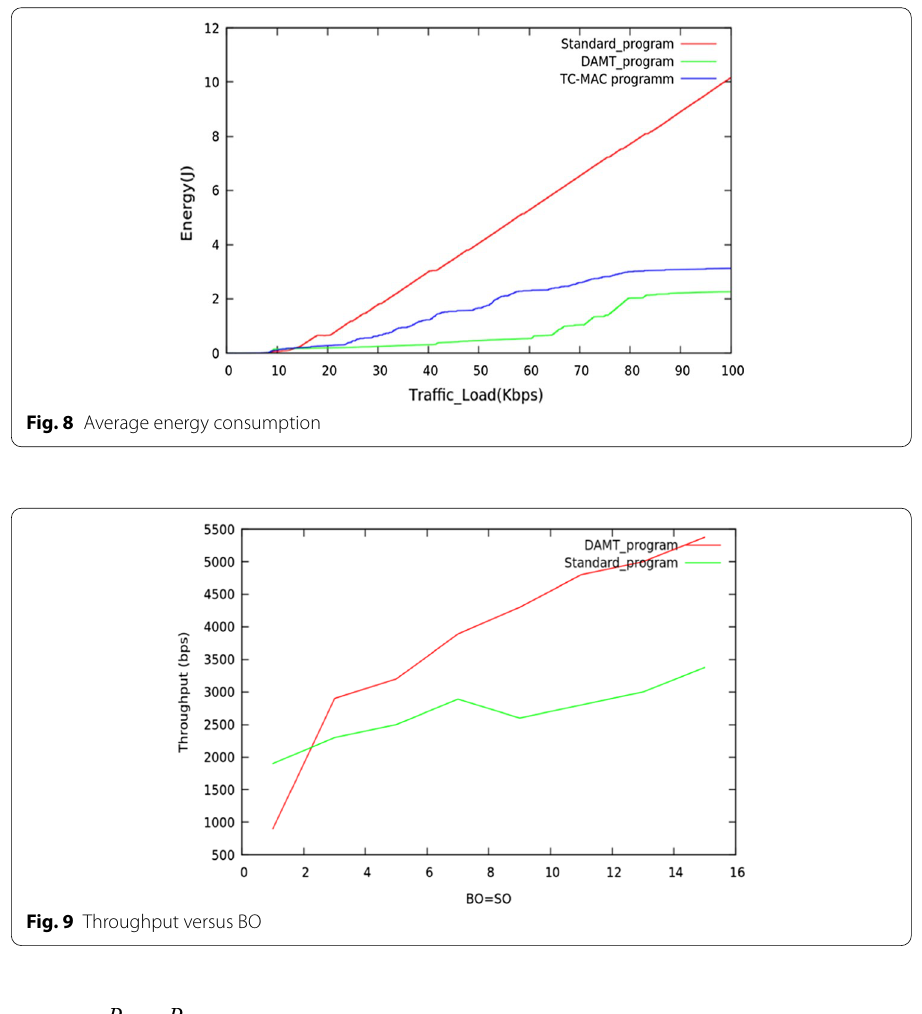
Energy consumption is a critical issue in WSN. The comparison between the pro- posed algorithm and the DAMT algorithm and the IEEE-802.15.4 standard is shown in Fig. 8. This figure presented the energy consumption variation against the traffic load. It depicts that the energy rises gradually as a function of traffic load. For low traffic loads of 100 kbps, the maximum energy consumed is 10 J and this occurs in case of the unprioritized network. On the other hand, the prioritized network attains consumed energy of 2 J; however, the TC-MAC algorithm attaints a value of 3 J. As seen, the average energy consumption of the hybrid and the TC-MAC program are less compared to the IEEE-802.15.4 standard unless the hybrid consumes well the power